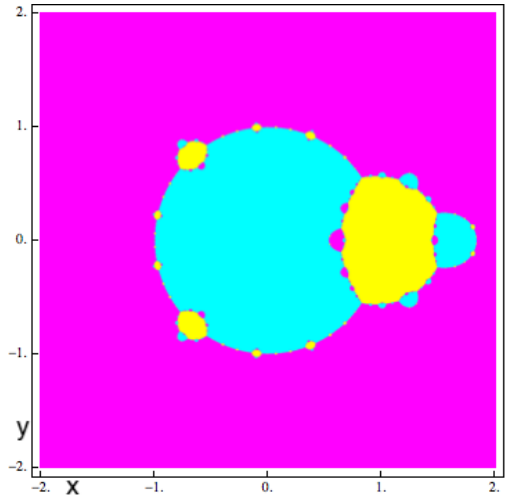
Figure 6. Basins of attraction associated with the member r = 1 and t = 1.